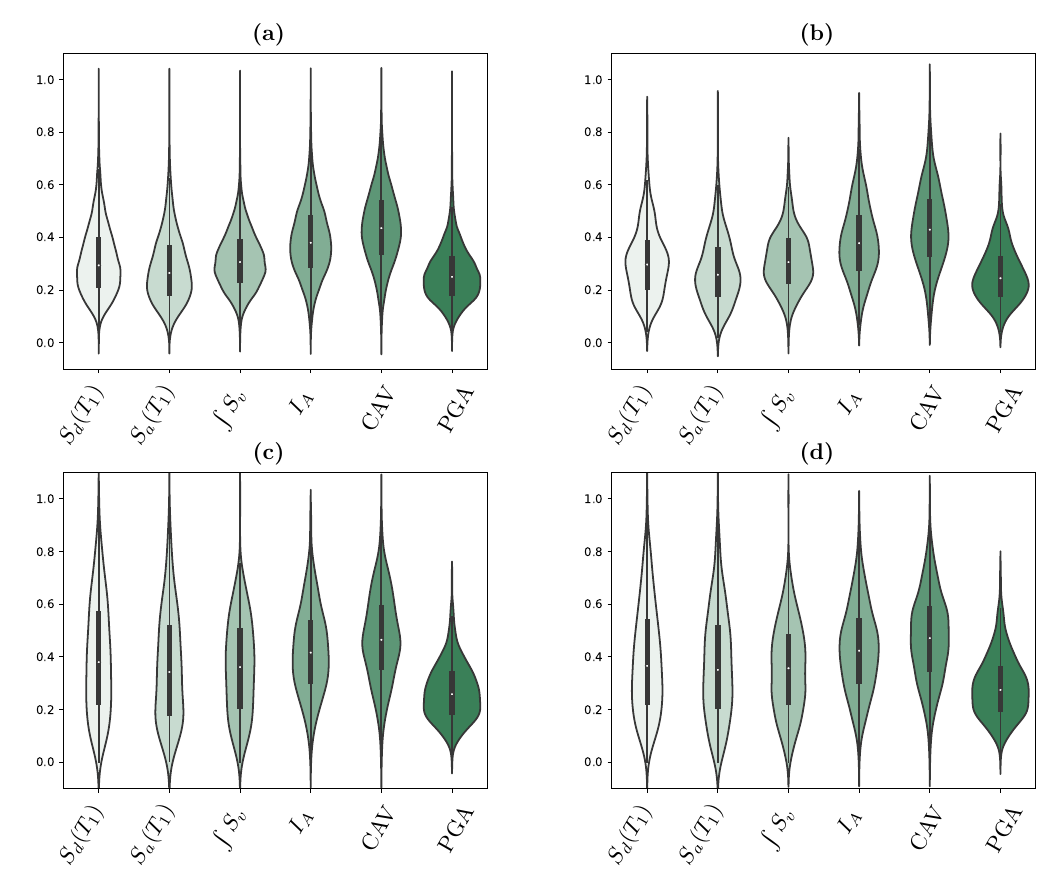
Figure 12. Violin plots [52,53] show the distribution of the intensities, which are used as inputs for the neural network; ( a ) full set, 10,000 samples; ( b ) 500 randomly chosen samples from the full set; ( c ) 438 samples are chosen as training data based on the proposed strategy using two 2.5 S v and the spectral displacement S d ( T 1 ) ) with 34 bins each; intensities (velocity spectrum intensity 0.1 ( d ) 565 samples are chosen as training data based on the proposed strategy using three intensities (cid:82) 2.5 S v , the spectral displacement S d ( T 1 ) and the spectral acceleration (velocity spectrum intensity 0.1 S a ( T 1 ) ) with 19 bins each. (cid:82)